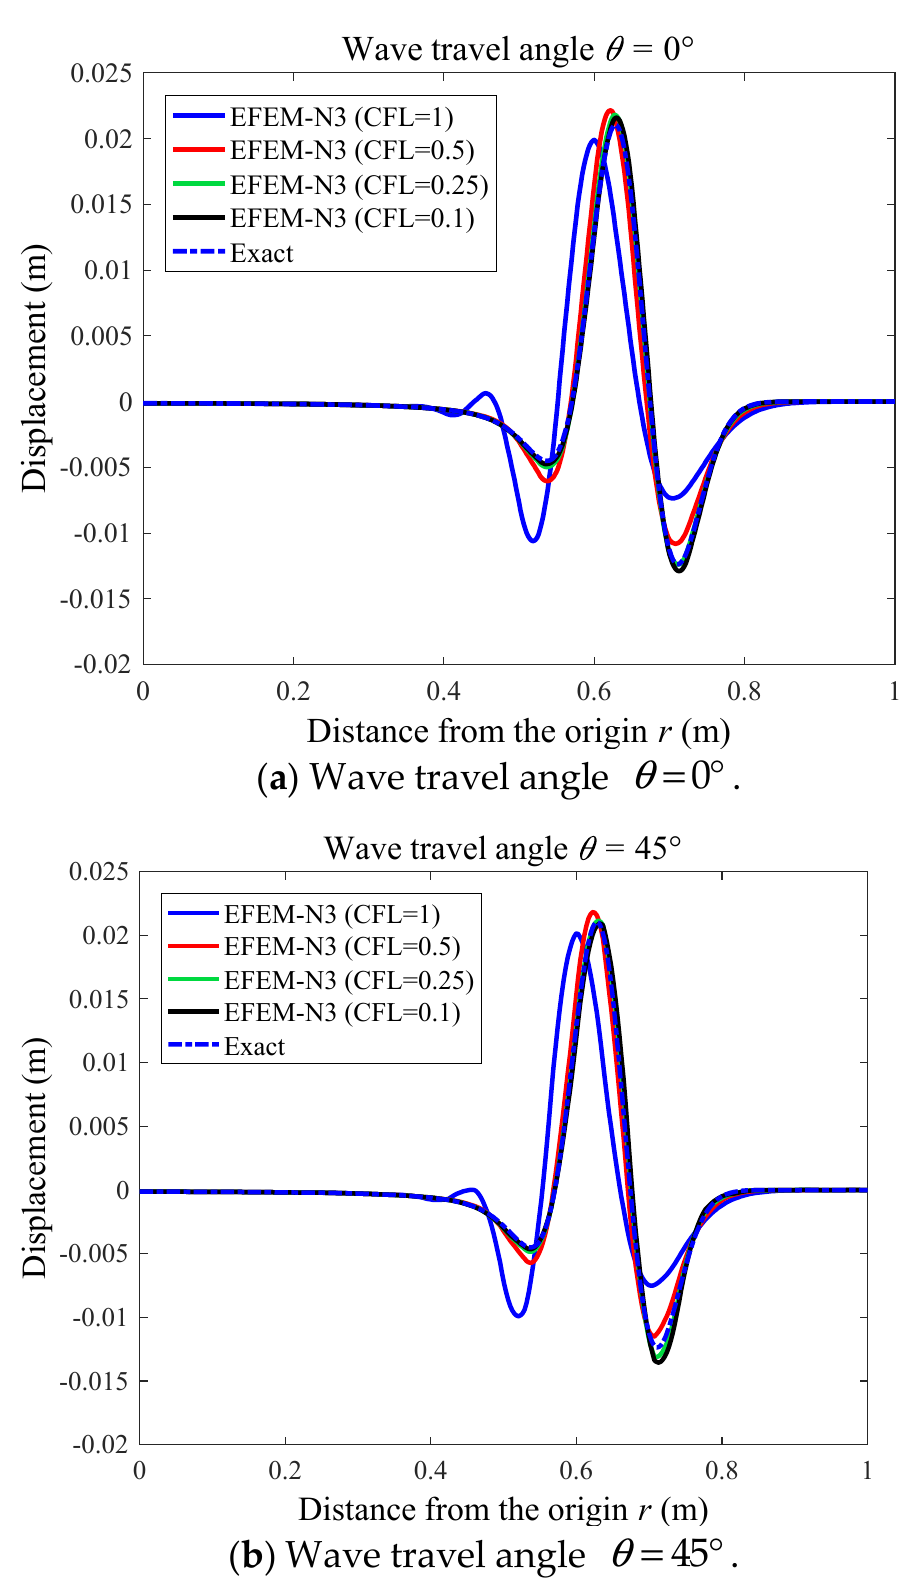
Figure 10. The displacement responses of the square membrane from the EFEM-N3 by varying the employed nondimensional temporal discretization interval.